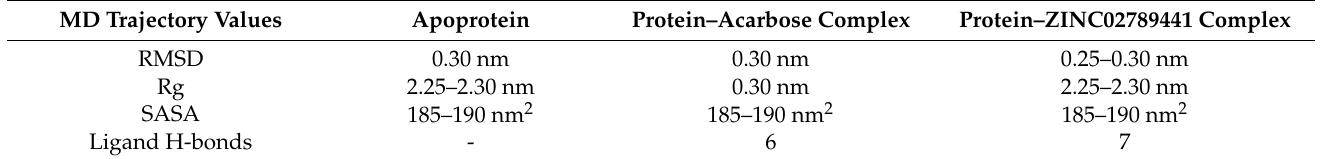
Table 9. MD trajectory values obtained for ZINC02789441and acarbose complexed with α -amylase.